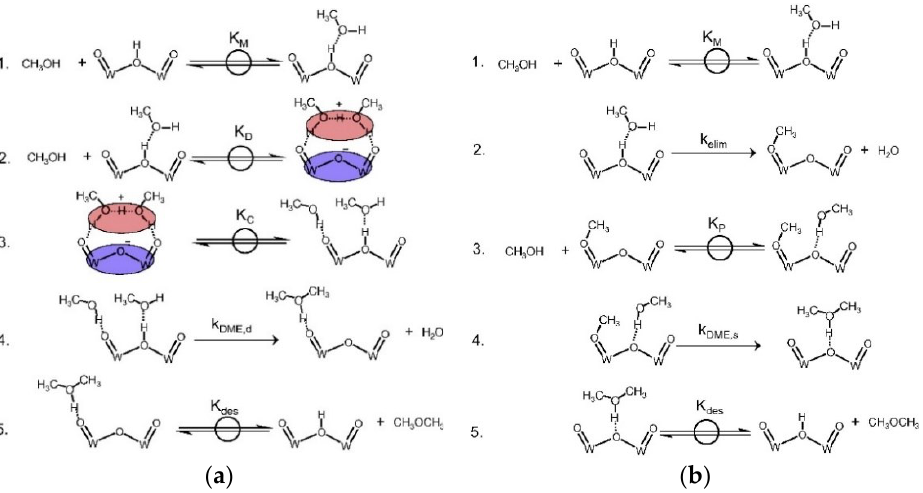
Figure 9. Elementary steps of MeOH dehydration on tungsten Keggin polyoxometalate (POM) clusters considered in [74]. ( a ) The associative pathway and ( b ) the dissociative pathway. Reprinted with permission from [74]. Copyright (2011) Elsevier.